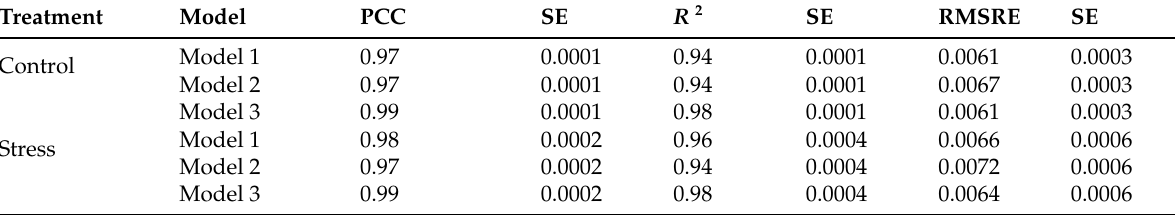
Table 2: The comparison of three proposed models using PCC, R 2 , and RMSRE.